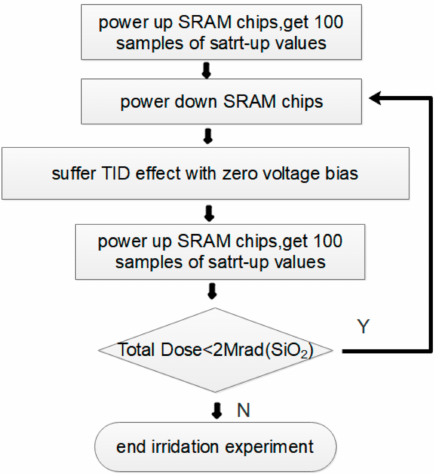
Figure 3. Steps of proposed SRAM power-on characteristics improvement utilizing irradiation exposure.